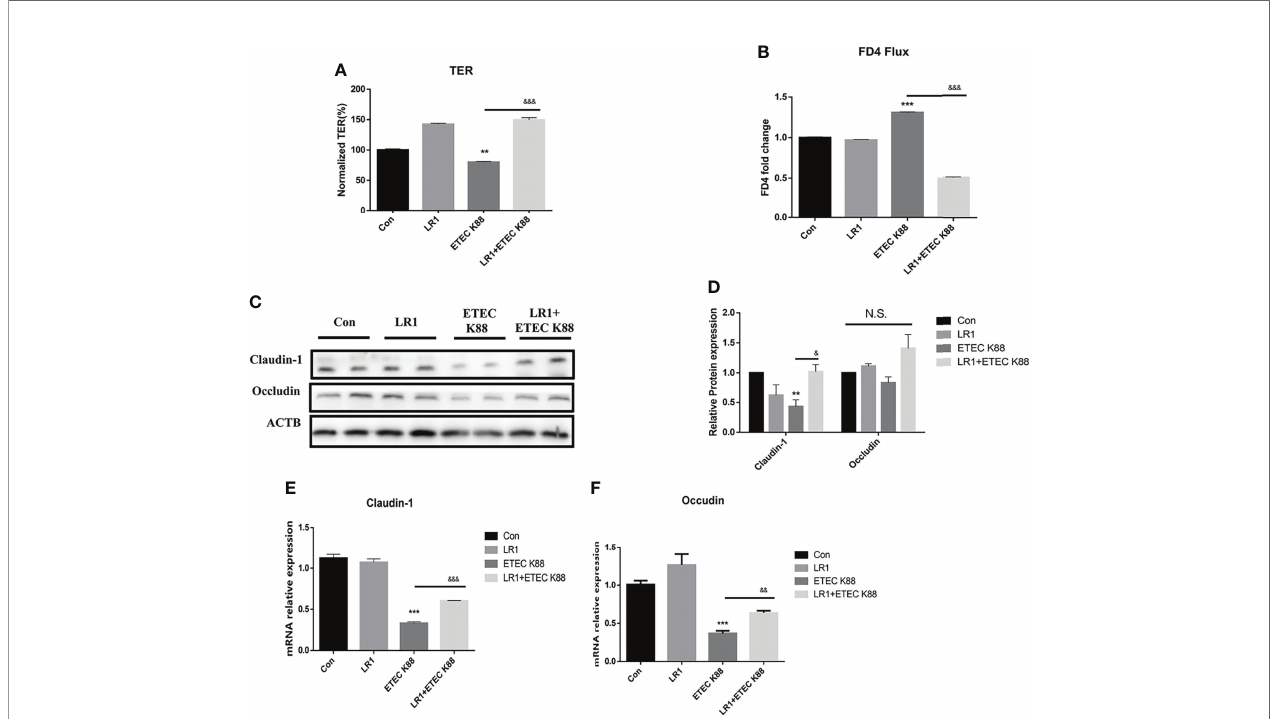
FIGURE 4 | Effects of L. reuteri LR1 on intestinal epithelial barrier function and tight junction protein expression in IPEC-J2 cells treated with ETEC K88. (A) The effect of L. reuteri LR1 (1 × 10 9 cfu/ml) on transepithelial electrical resistance (TER) in IPEC-J2 cells treated with ETEC K88 (1 × 10 8 cfu/ml). (B) The effect of L. reuteri LR1(1 × 10 9 cfu/ml) on FD4 fl ux in IPEC-J2 cells treated with ETEC K88 (1 × 10 8 cfu/ml). (C) The effect of L. reuteri LR1 (1 × 10 9 cfu/ml) on tight junction protein expression in IPEC-J2 cells treated with ETEC K88 (1 × 10 8 cfu/ml). (D) Quanti fi cation of tight junction protein expression. (E) The effect of L. reuteri LR1 (1 × 10 9 cfu/ml) on Claudin-1 gene expression in IPEC-J2 cells treated with ETEC K88 (1 × 10 8 cfu/ml). (F) The effect of L. reuteri LR1 (1 × 10 9 cfu/ml) on Occludin gene expression in IPEC-J2 cells treated with ETEC K88 (1 × 10 8 cfu/ml). Cells were treated with L. reuteri LR1 (1 × 10 9 cfu/ml) for 4 h, and then followed by ETEC K88 (1 × 10 8 cfu/ml) for 4 h. Data presented as mean ± SEM ( n = 3). ** p < 0.01 and *** p < 0.001 vs. the control group, && p < 0.01 and &&& p < 0.001 vs. the ETEC K88 group. N.S., not signi fi